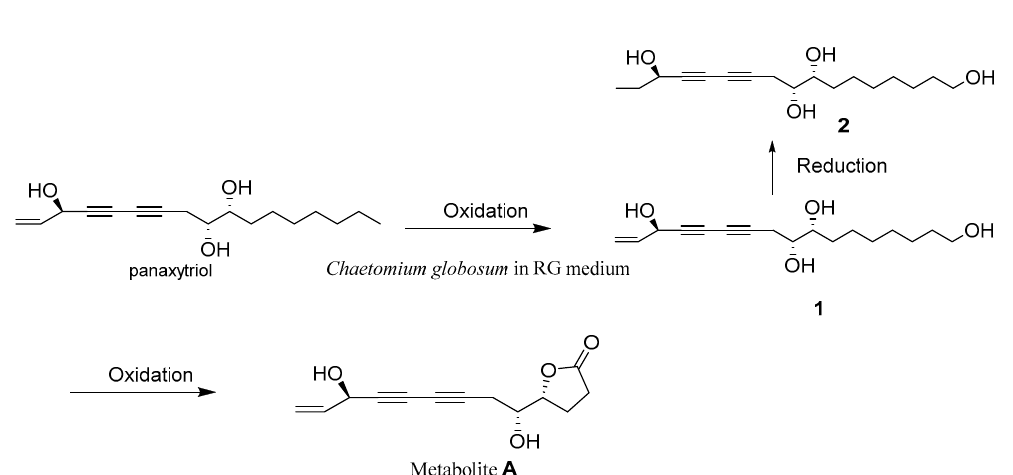
Figure 4. The plausible biotransformation of panaxylactone (metabolite A ).